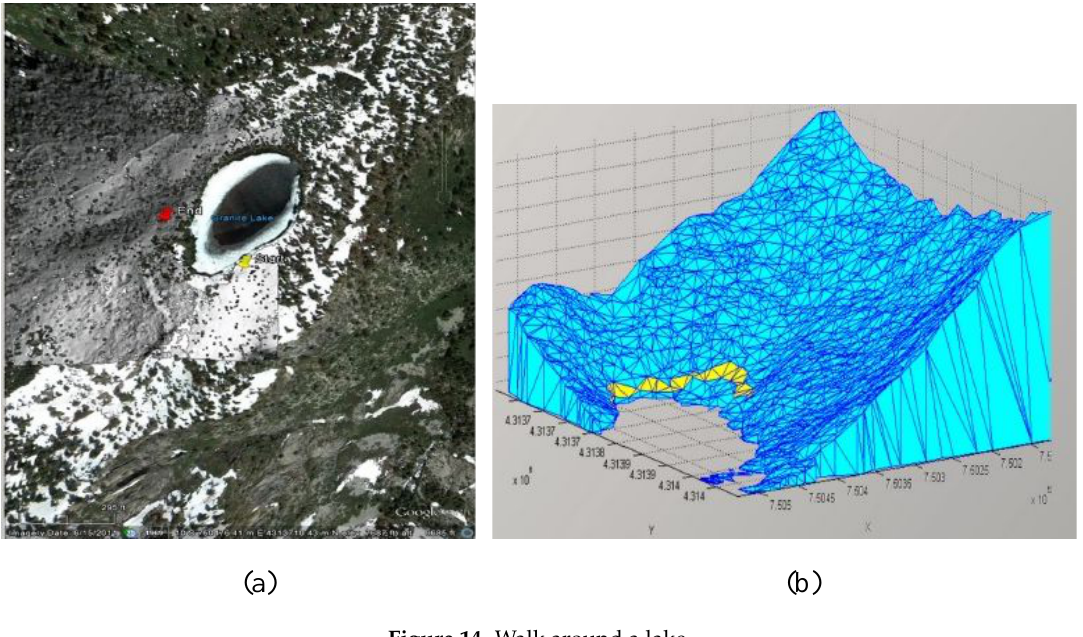
Figure 14. Walk around a